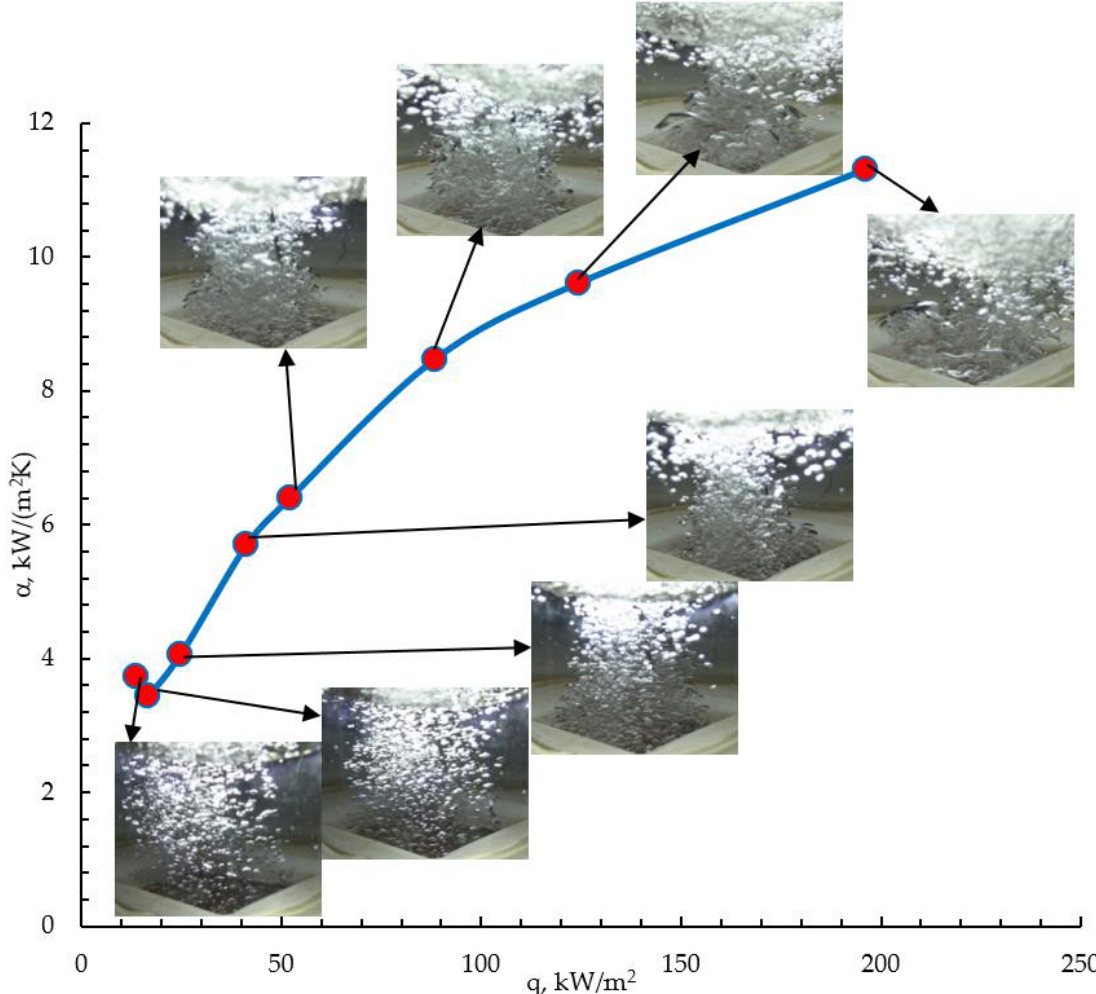
Figure 12. Pool boiling curve visualization for surface with microchannels MC-0.3-0.3-0.6-30.